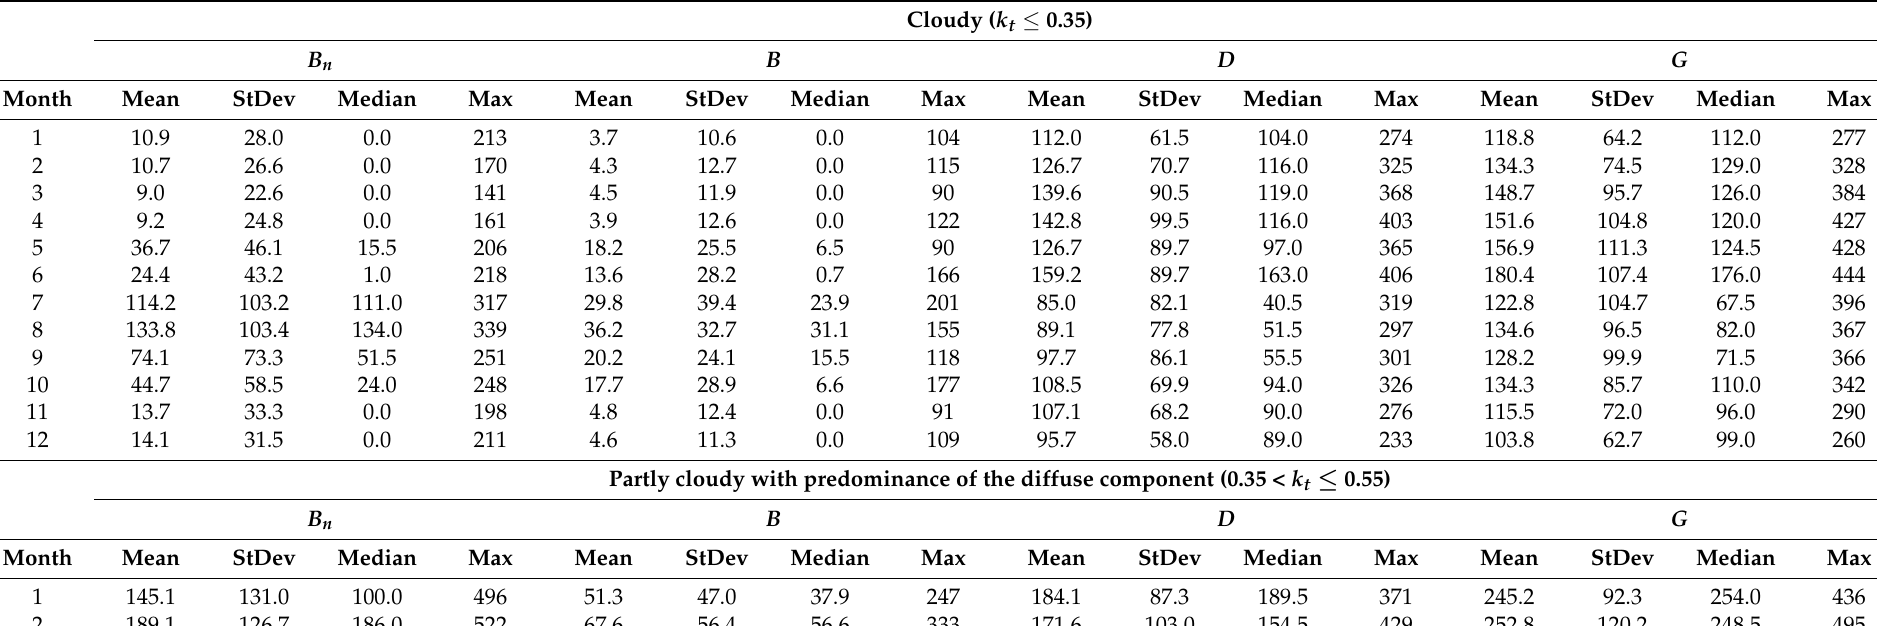
Table 7. Monthly statistics of direct normal ( B n ), direct horizontal ( B ), diffuse ( D ) and global irradiance ( G ) in (W/m 2 ) for cloudy, partially cloudy and clear sky